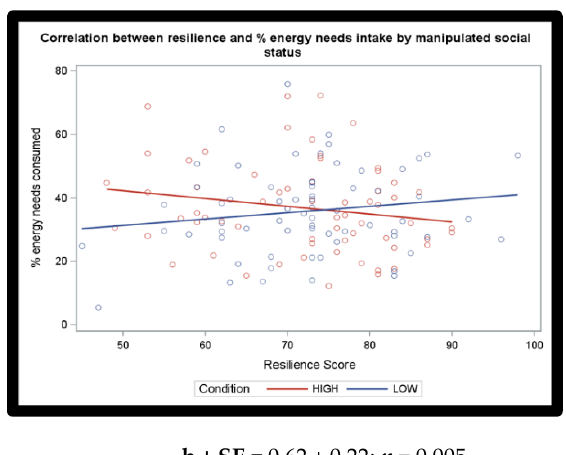
Figure 1. Correlation graphs and p -values from regression models assessing whether psychological resilience significantly moderates The relationship between high and low SS conditions and dietary intake.